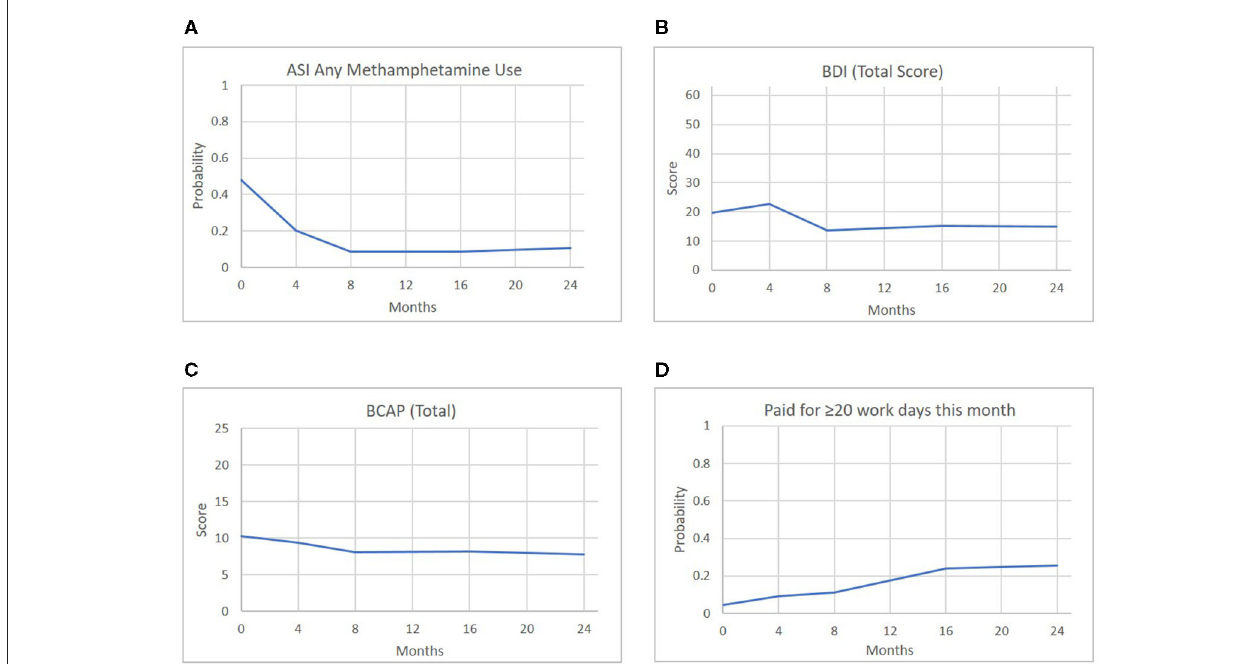
FIGURE 4 | Predicted scores of representative outcomes across the four FAIR domains over time.